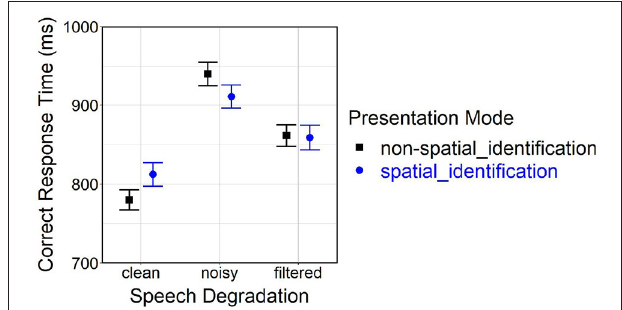
FIGURE 4 | Effects of presentation mode and speech degradation on correct response time. Error bars represent 95% confidence intervals. Another version of this figure originally appeared in Uhrig (2022), copyright 2021, with permission from Springer.